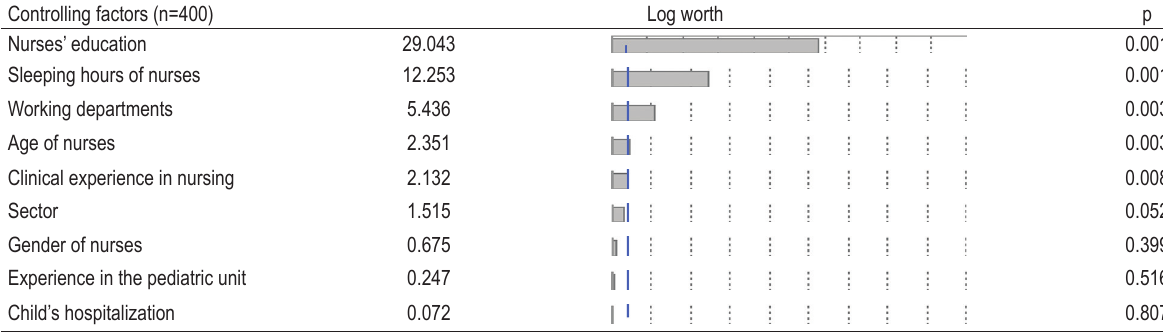
TABLE 5. Role of general and clinical characteristics on total clinical performance score in a fit model Controlling factors (n=400)